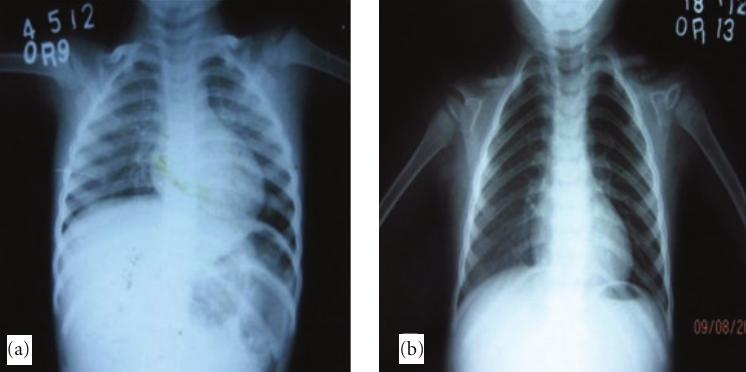
Figure 7: Chest radiograph: (a) patient and (b)